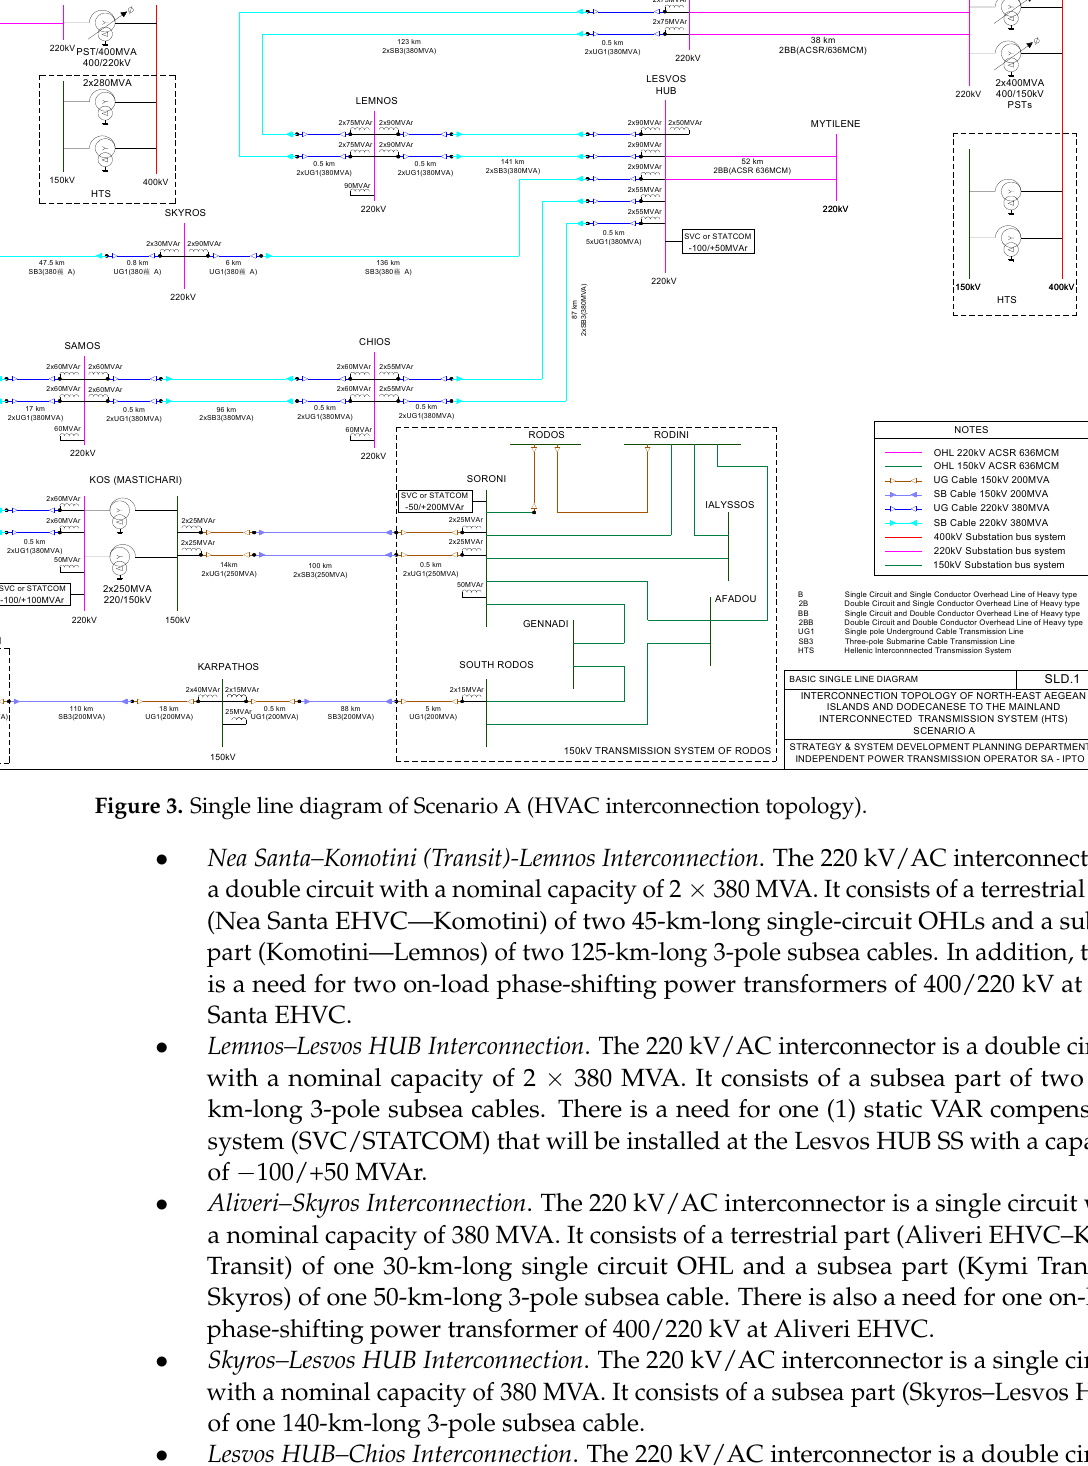
Figure 4. Single line diagram of the Scenario B (mixed HVDC and HVAC interconnection topology).